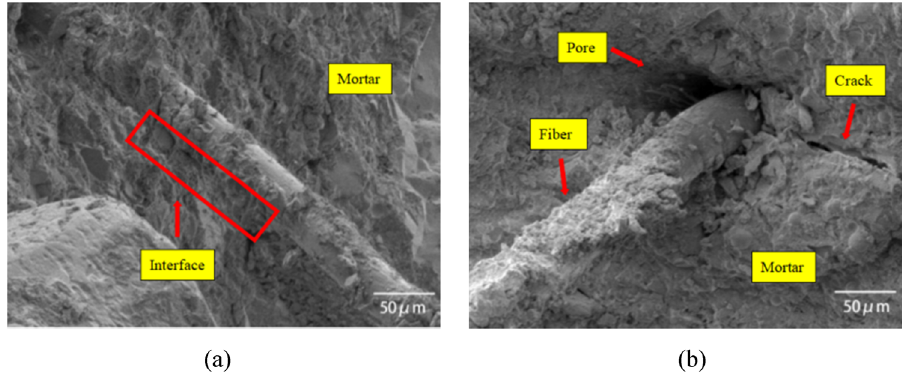
Figure 10: The SEM images of PVA fi ber in B 2 specimen. ( a ) Fiber surface and ( b ) fi ber